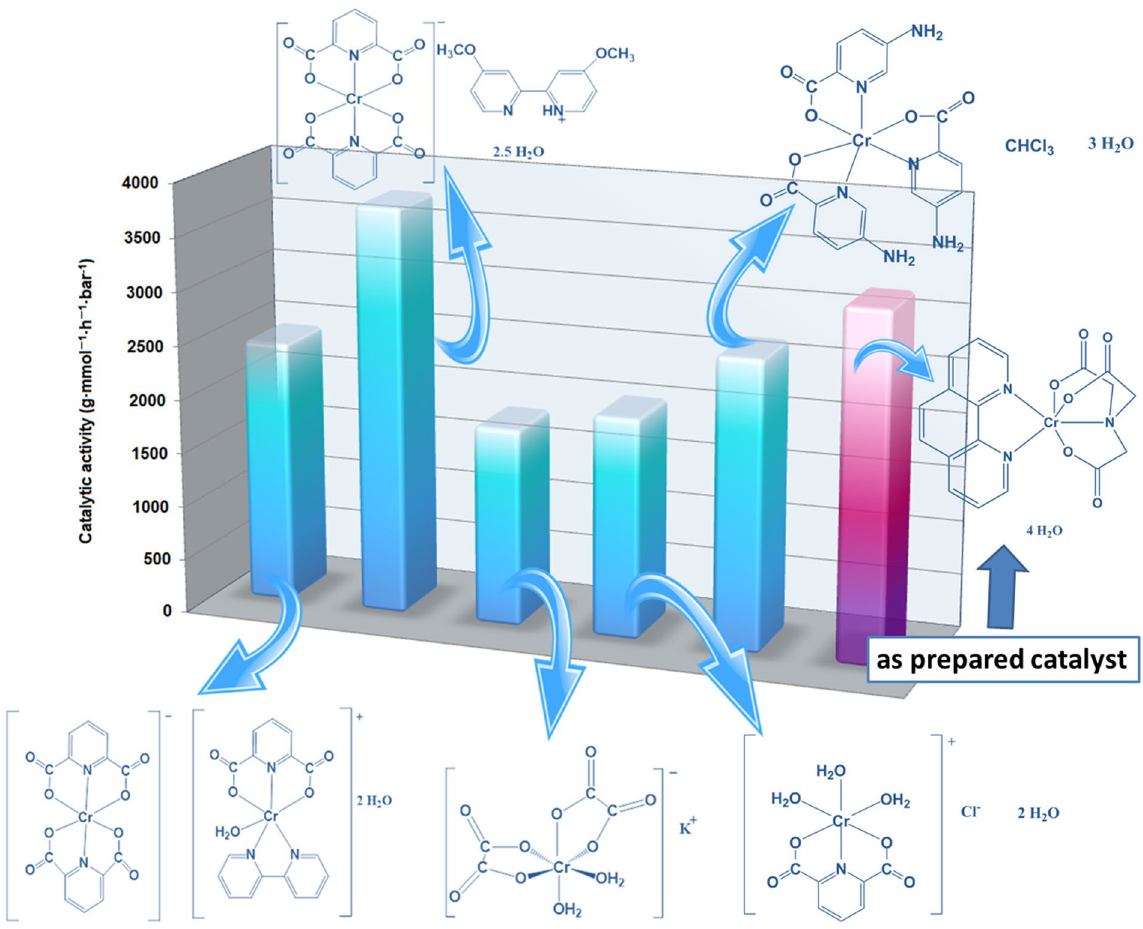
Figure 5. The catalytic activities of Cr(III) complexes for ethylene oligomerization based on 35